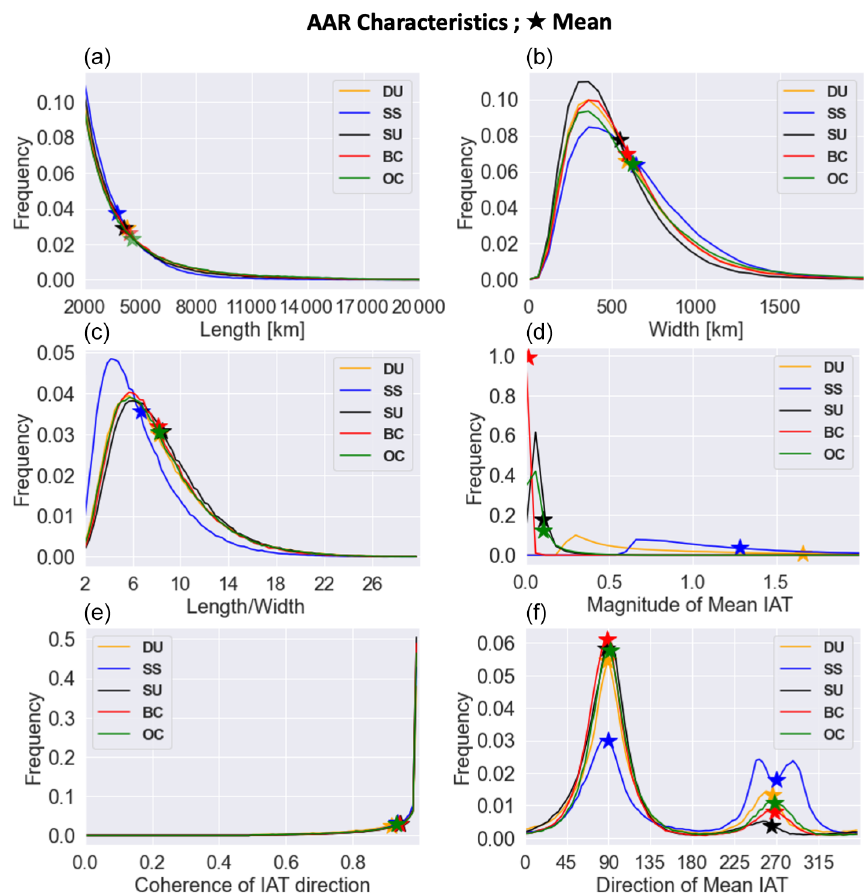
Figure 8. Histograms of characteristics of individual AARs. The star ( (cid:63) ) symbols denote the mean. (a) Length. (b) Width. (c) Aspect ratio. (d) Magnitude of mean IAT. (e) Coherence of the IAT direction. (f) Direction of mean